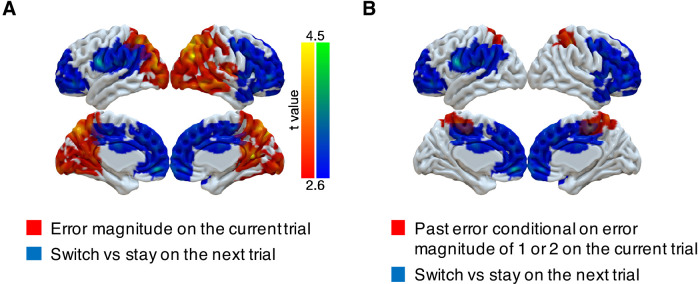
Representations of subsequent behavioral choices (switch versus stay) after ambiguous small errors in the noisy condition.(A) Overlap of results for switch versus stay on the next trial and error magnitude on the current trial. Multi-voxel neural patterns were used to classify whether participants switch their choice to another target or stay on the same target on the next trial. We focused on the most ambiguous errors (error magnitude of 1 or two in the noisy condition). Above-chance classification performance was found in a large cluster encompassing the frontal lobe. The cluster-forming threshold was an uncorrected voxel p<0.01 (t = 2.6), with cluster mass corrected for multiple comparisons using non-parametric permutation tests. (B) Overlap of results for switch versus stay on the next trial and past error conditional on error magnitude of 1 or two on the current trial.